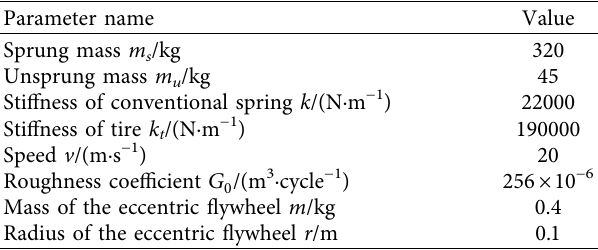
Table 1: Parameters of the mature suspension